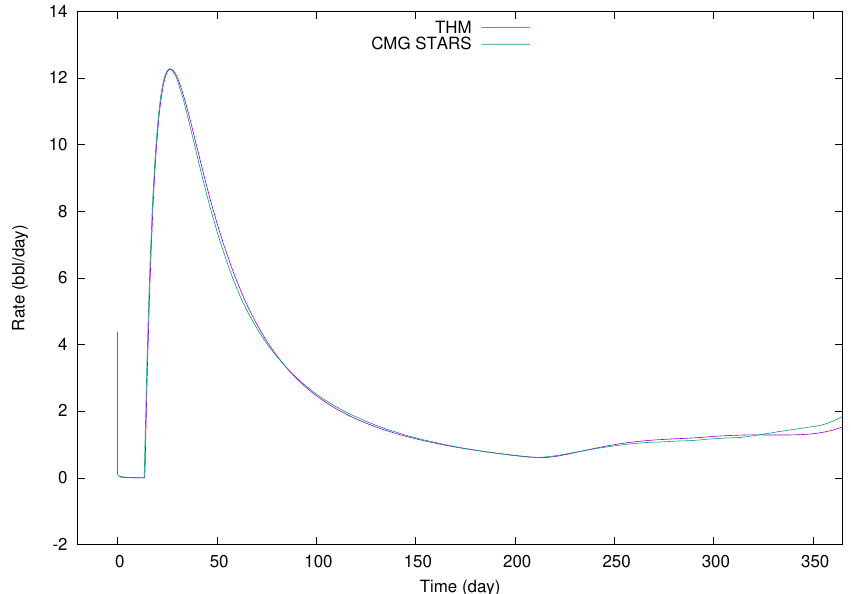
Figure 10. Example 2: water production rate (bbl/day), first production